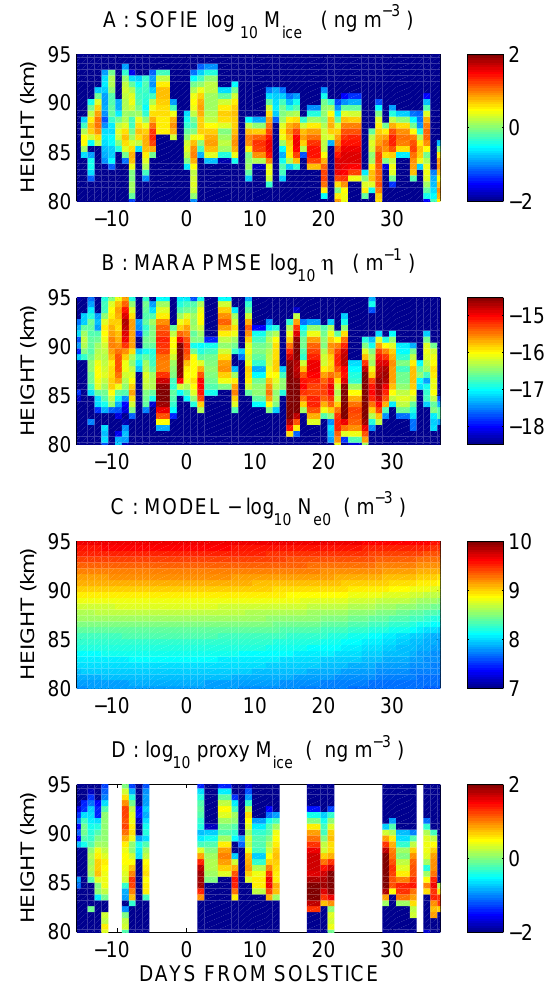
Fig. 2. Profiles of ice mass density measured by SOFIE (panel A ) and of PMSE volume reflectivity measured by MARA (panel B ) for the period 6 December 2007–30 January 2008. Panel (C) shows model values of background electron density and the panel (D) shows a proxy for ice mass density calculated using observed PMSE volume reflectivity and model electron densities (see text for further